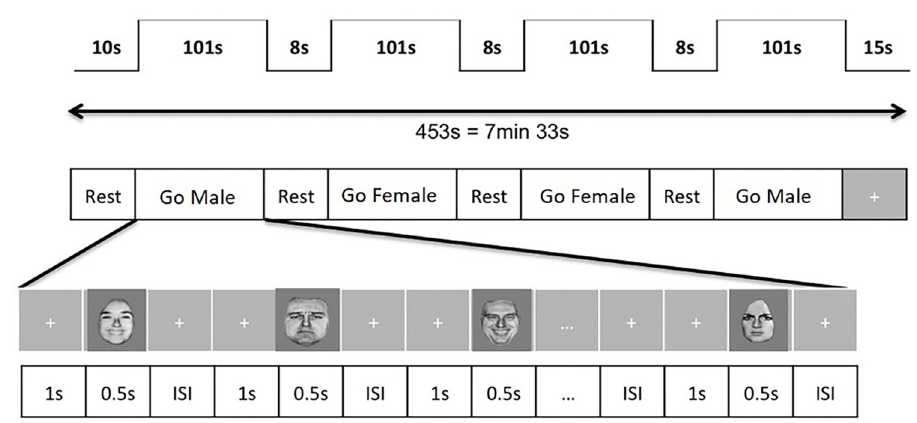
Fig 4. Emotional Go / No go sequence scheme. ISI: random time interval (2 to 6 seconds).